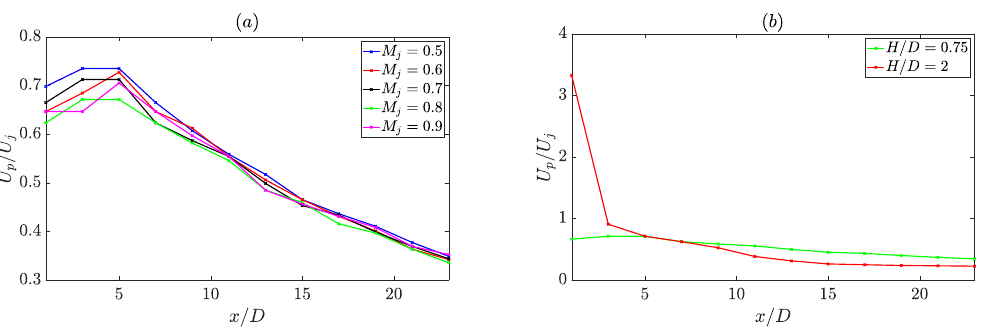
Figure 8. Wall pressure phase speed trends: ( a ) Mach effect at H/D = 0.75; ( b ) H/D comparison at M j =